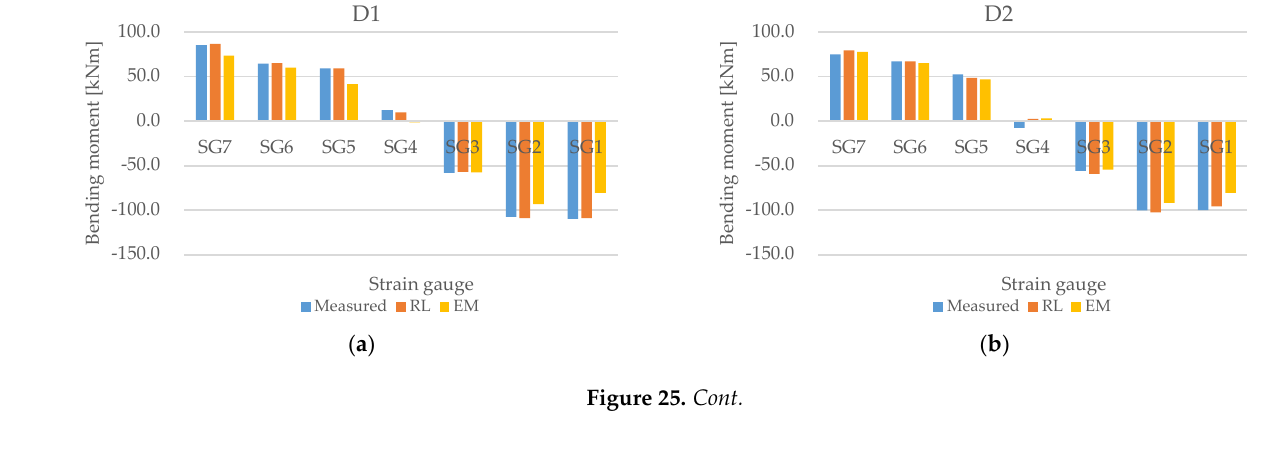
The comparison results of the reaction force prediction in Figure 24 demonstrate that